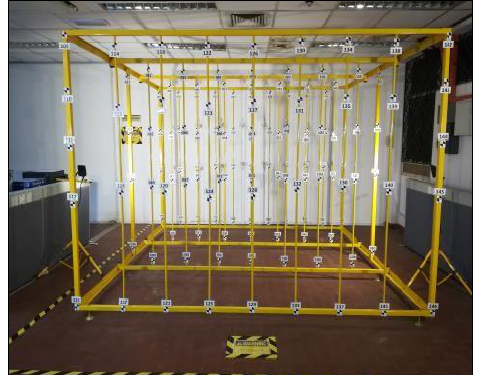
Figure 8 The distance between two markers in X, Y and Z coordinate